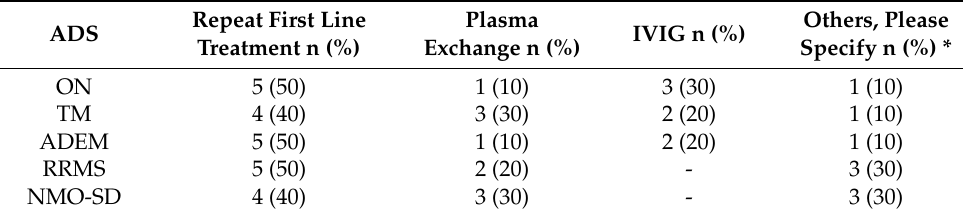
Table 3. The use of second-line treatment.